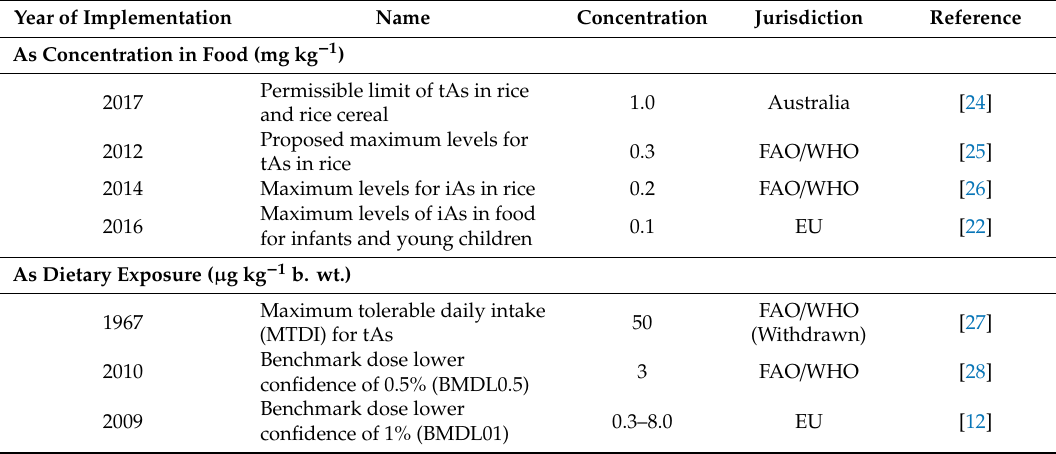
Table 1. Guidelines for arsenic concentration and arsenic dietary exposure. Year of Implementation Name Concentration Jurisdiction